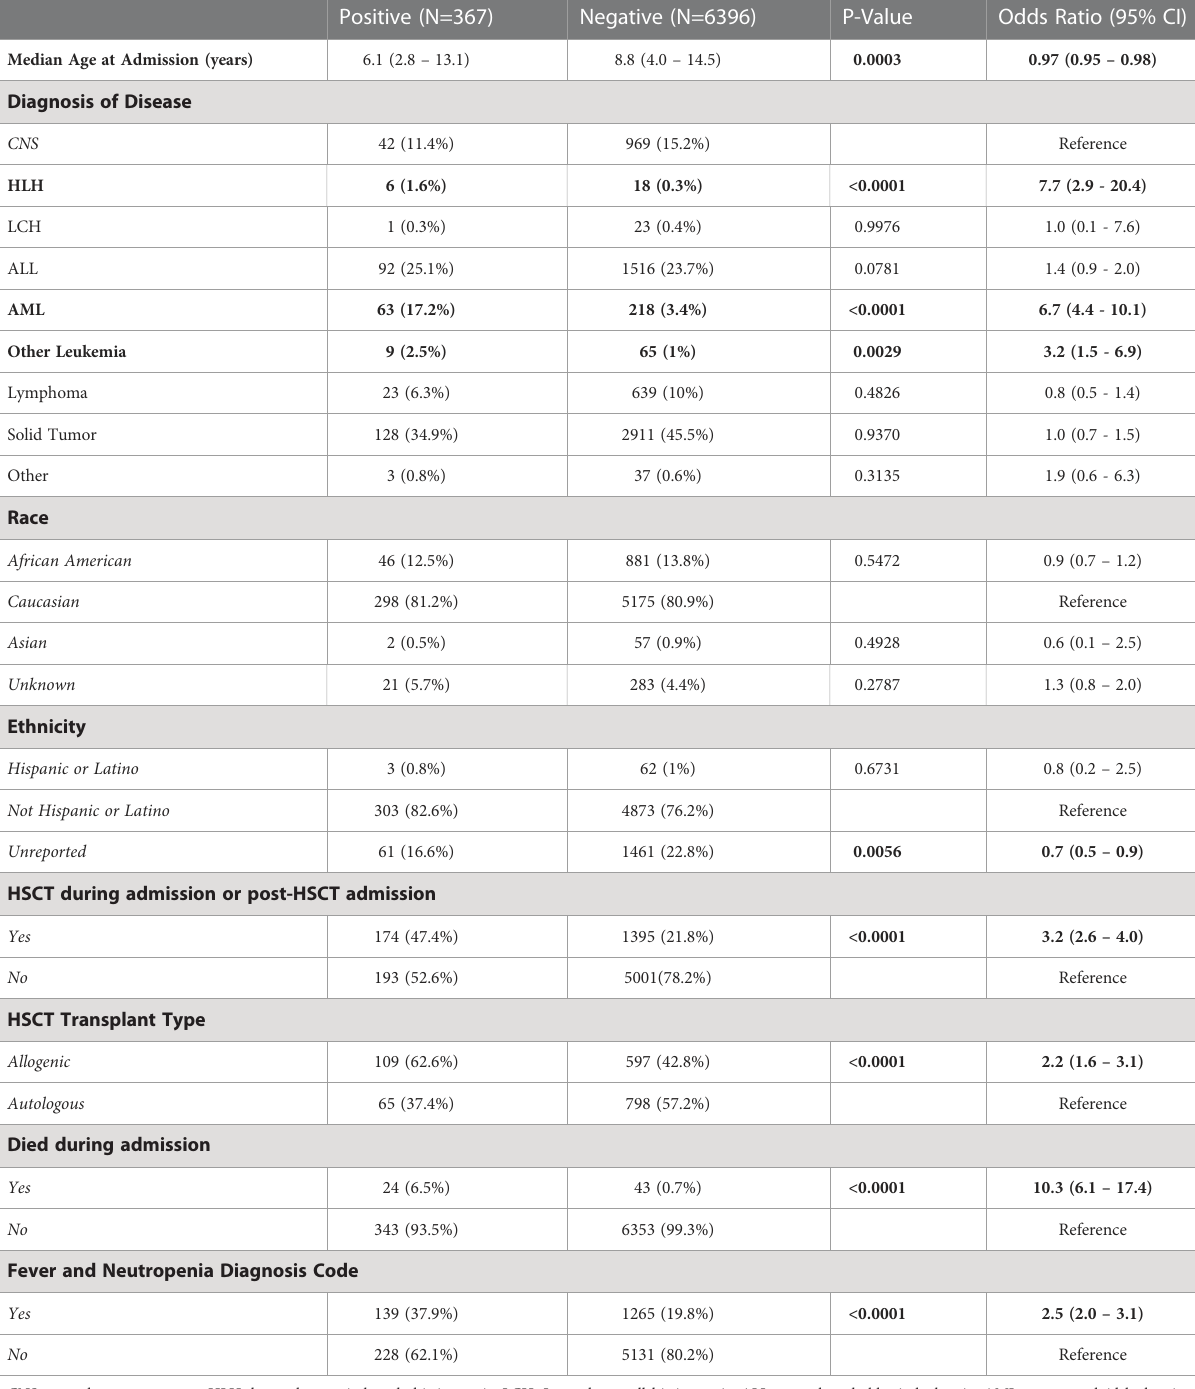
TABLE 3 Univariate analysis of risk factors associated with positive blood cultures during admission